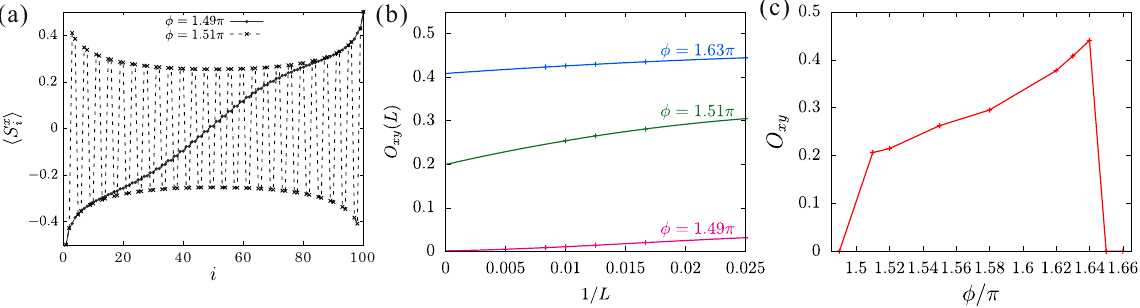
Figure 7. ( a ) The x -component of local spin, where opposite magnetic fields ± 10 are applied at either end of the system. ( b ) Finite-size scaling analyses for the staggered- xy order parameter with polynomial fitting functions. ( c ) The extrapolated values of  to the themodynamic limit as a function of φ xy